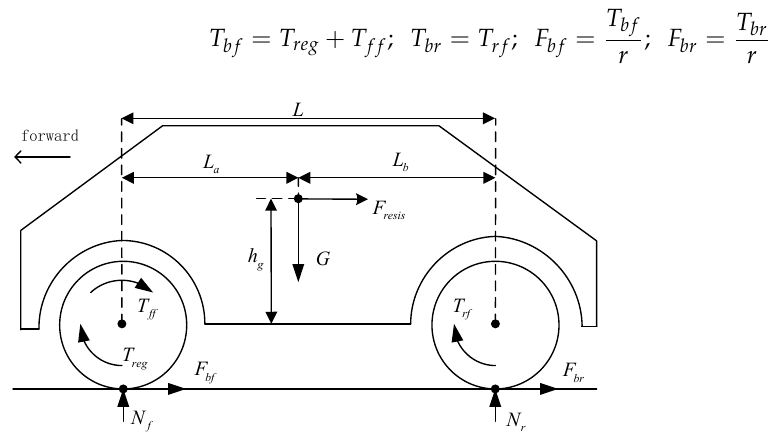
Figure 1. Forces acting on a vehicle while braking on the level ground [32].